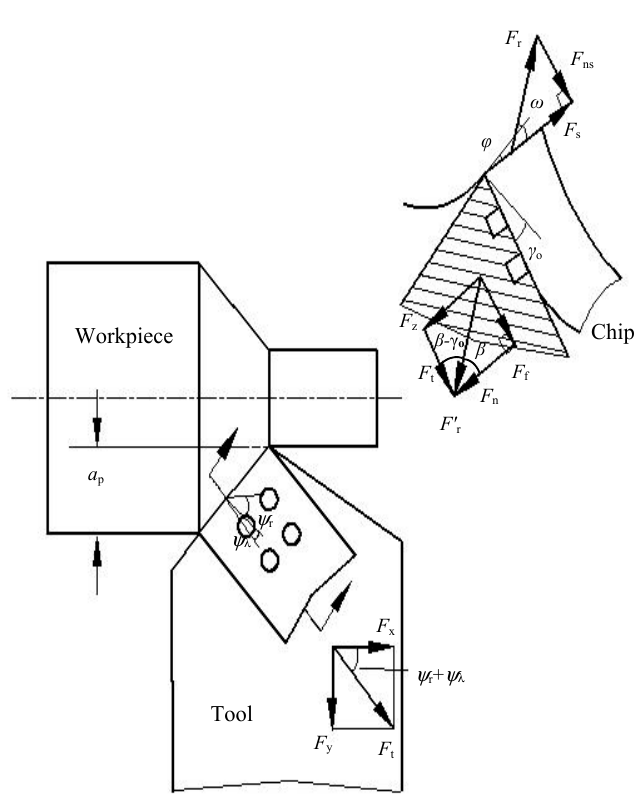
Figure 16. Simplified model of oblique cutting.